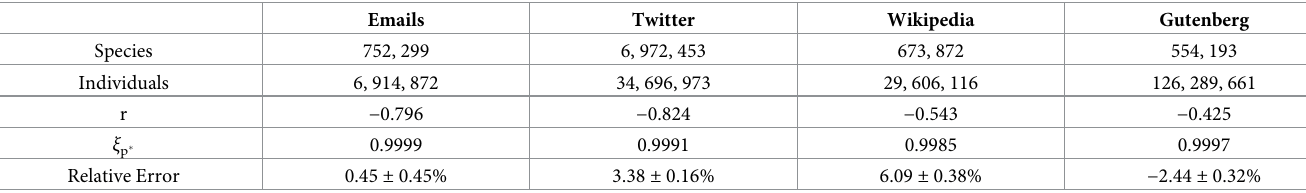
Table 1. Predicted relative errors. Upscaling results for the number of species of the four analysed datasets from local samples covering a fraction p � = 5% of the corre- sponding global dataset. For each human activity, we display the number of species (users, hashtags, words) and individuals (sent mails, posts, occurrences) at the global scale together with the average fitted RSA distribution parameters at the sampled scale and the relative percentage error (mean and standard deviation among 100 trials) between the true number of species and the one predicted by our framework. See S1 Fig in S1 Appendix for the corresponding fitting curves and predicted global RSA